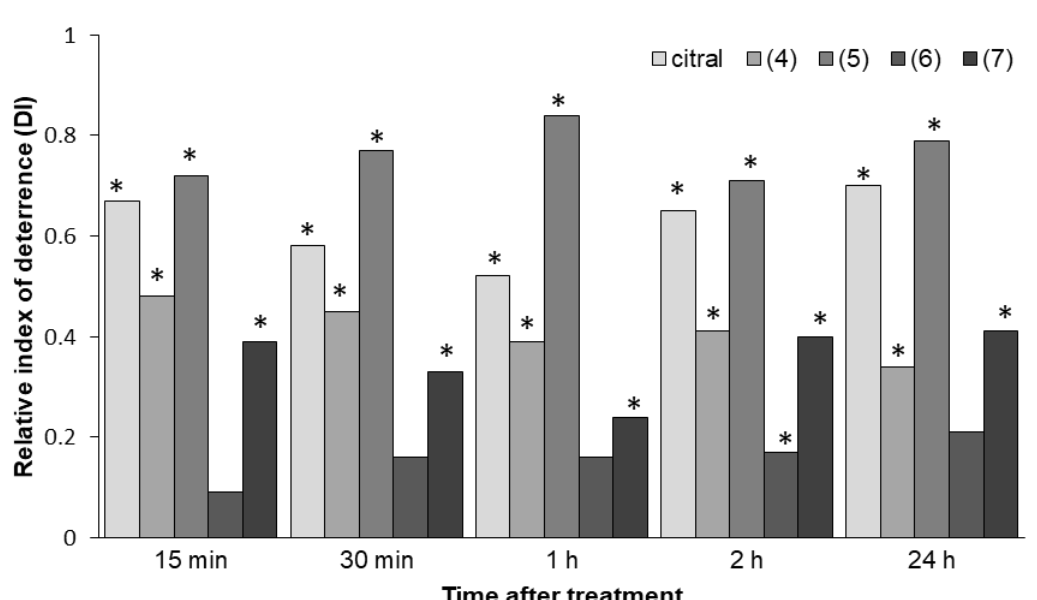
Figure 2. Relative indices of deterrence (DI) of citral and citral-derived lactones towards Myzus persicae ; β , γ -dimethyllactone ( 4 ), α -methylenelactone ( 5 ), γ -methylenelactone ( 6 ), α , γ -dimethylenelactone ( 7 ). Asterisk denotes statistically significant di ff erences at p ≤ 0.05 (Student t -test); DI = (C − T) / (C + T); DI < 0: attractant activity; DI > 0: deterrent